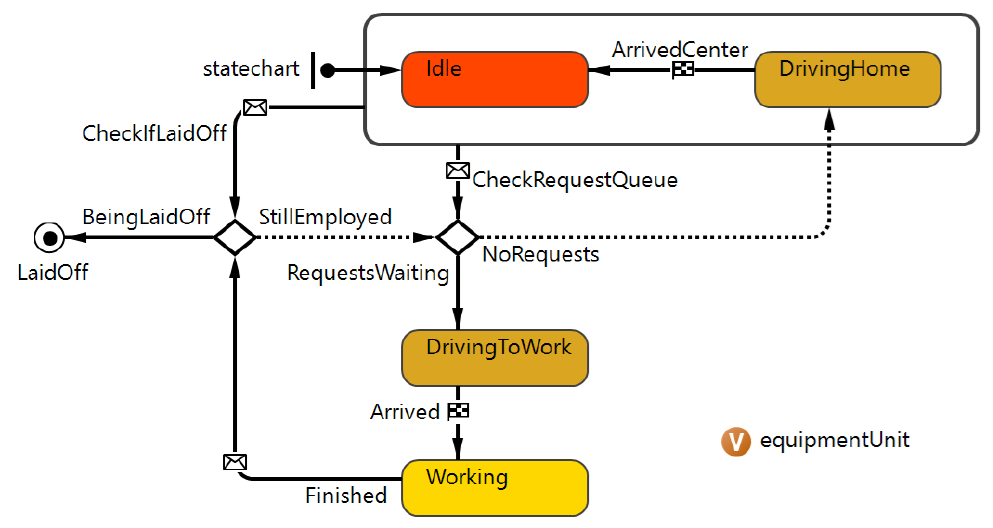
Figure 4. Stage chart showing the different possible states of the service crews, transitions between states, and decision places (lozenge-shaped symbols) (from Borshchev [6], pp. 179).